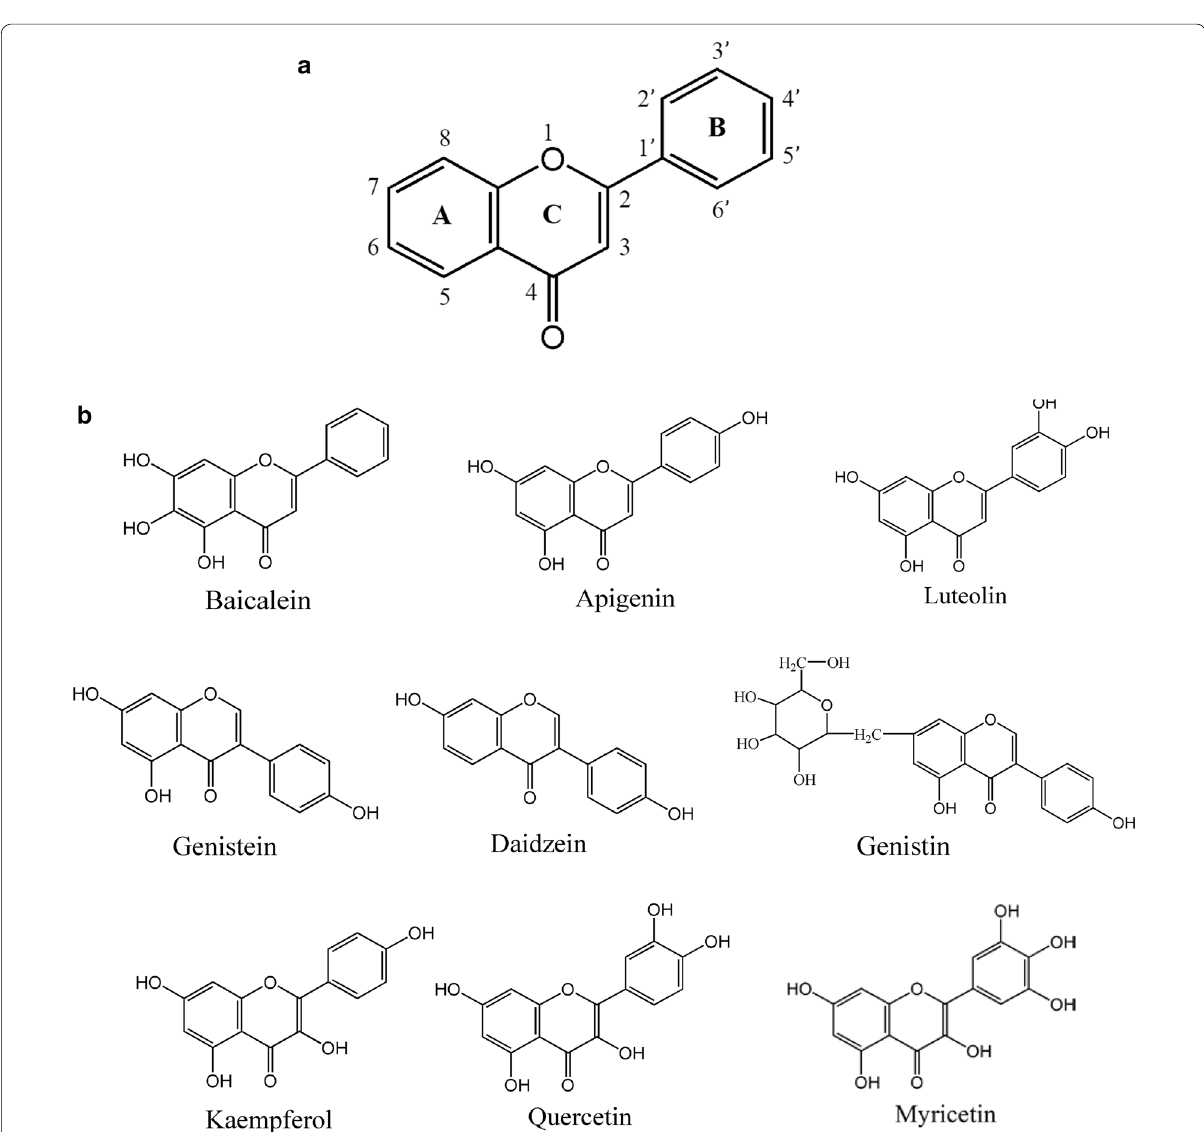
Fig. 1 a Matrix structure of flavonoids, and b structural formulas of different